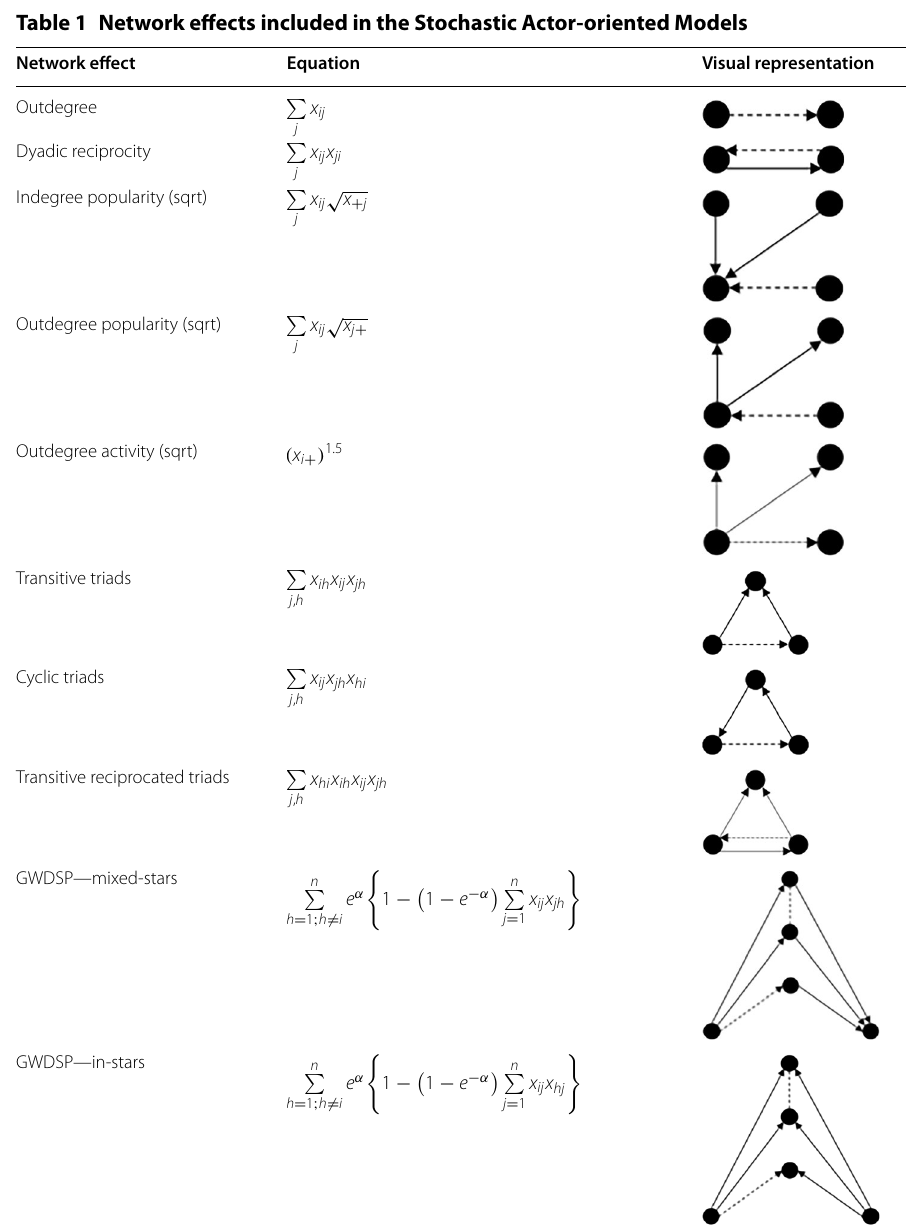
Table 1 Network effects included in the Stochastic Actor-oriented Models